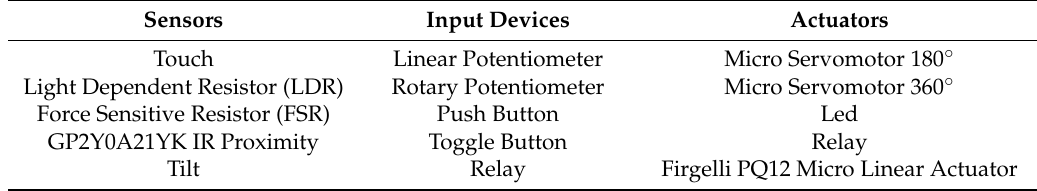
Table 2. List of sensors, input devices and actuators currently supported by the ECCE